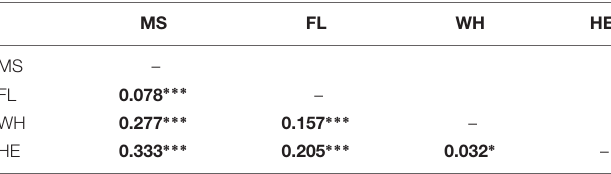
TABLE 1 | Pairwise comparison of genetic differentiation ( F ST ) between native and invasive Mnemiopsis leidyi sub-populations using highly polymorphic microsatellite markers.